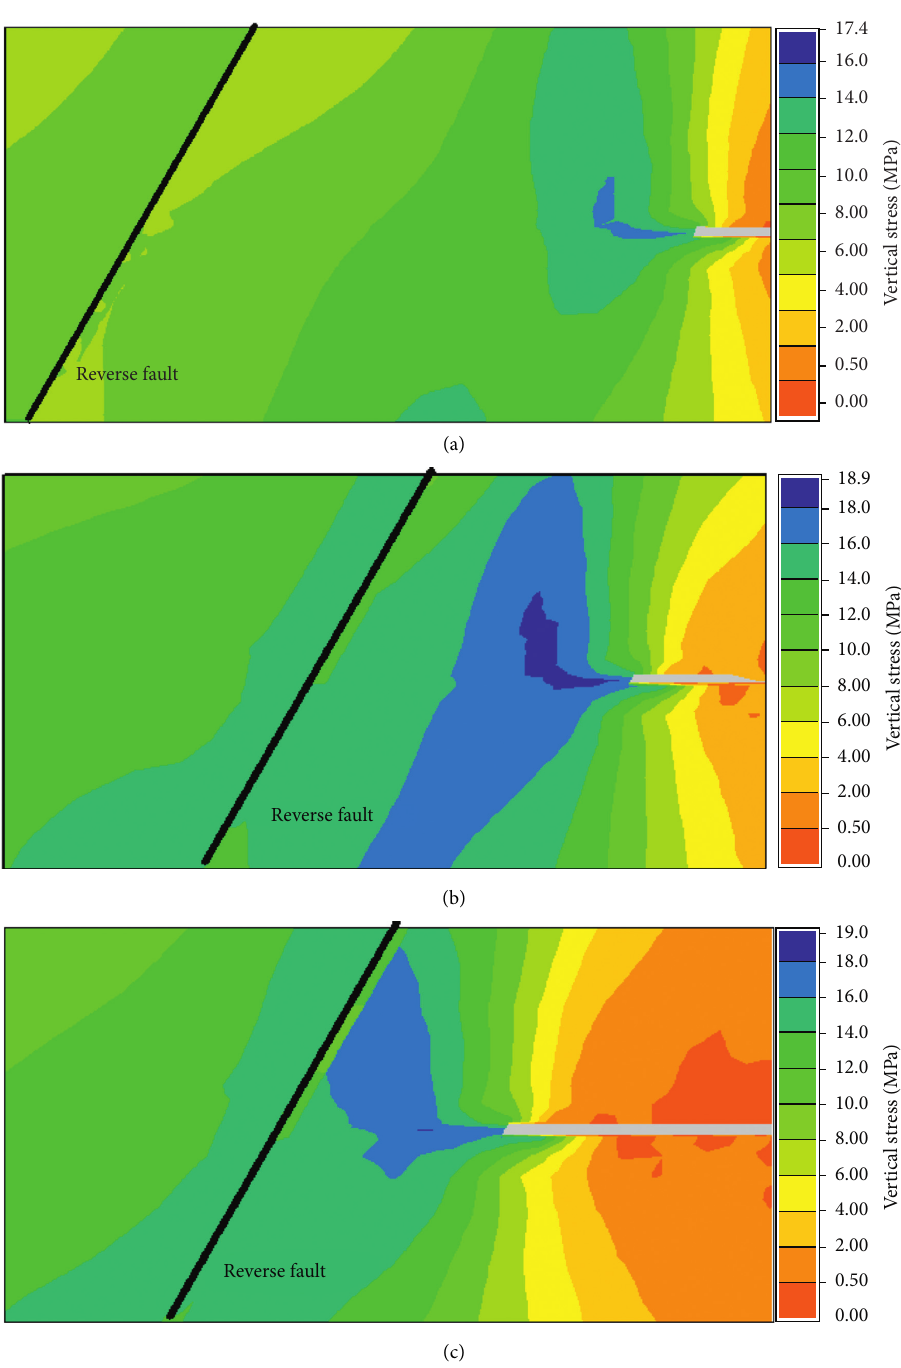
Figure 6: Variation of footwall mining-inflicted stress on the coal body under different distance between working face and reverse fault. (a) The working face is 70m away from the reverse fault. (b) The working face is 40m away from the reverse fault. (c) The working face is 10m away from the reverse